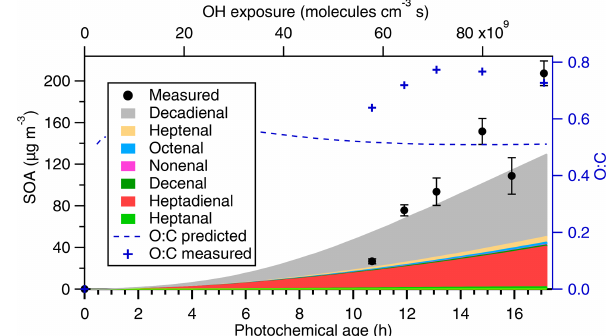
Figure 7. SOM prediction of SOA produced from different alde- hydes with increasing photochemical age. The model overpredicts SOA formation at lower photochemical age, while it underpredicts SOA formation by ∼ 40% at higher photochemical age, suggest- ing that traditional VOC precursors cannot fully explain the SOA formation, and other gas-phase precursors may be needed to bet- ter constrain the formation of SOA at higher aging conditions. In addition, the SOM-predicted O : C is within 50% of the measured O : C, suggesting that the overall change in chemical composition of cooking SOA is predicted reasonably